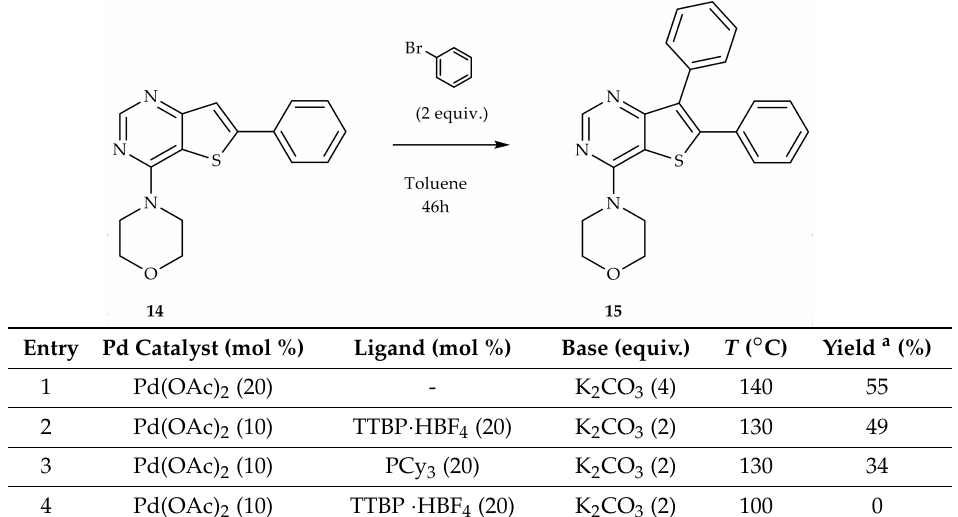
Table 5. Optimization of the C–H activation at position C-3 of 4-(6-phenylthieno[3,2- d ]pyrimidin-4- yl)morpholine 14